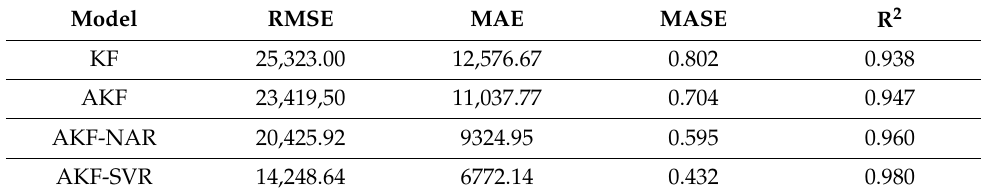
Table 2. Results for raspberry time series: 2019–2020 (weekly).